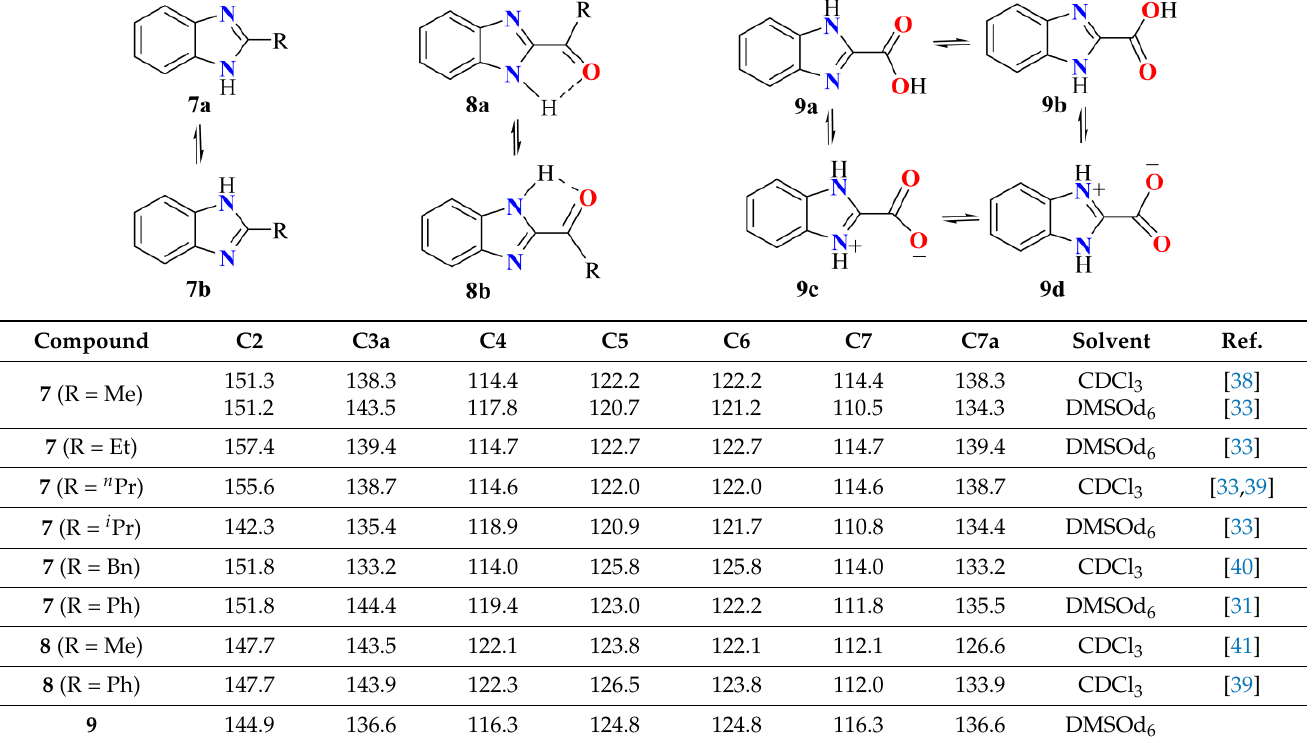
Table 5. Effects of 2-subtituted groups on the benzimidazole ring.